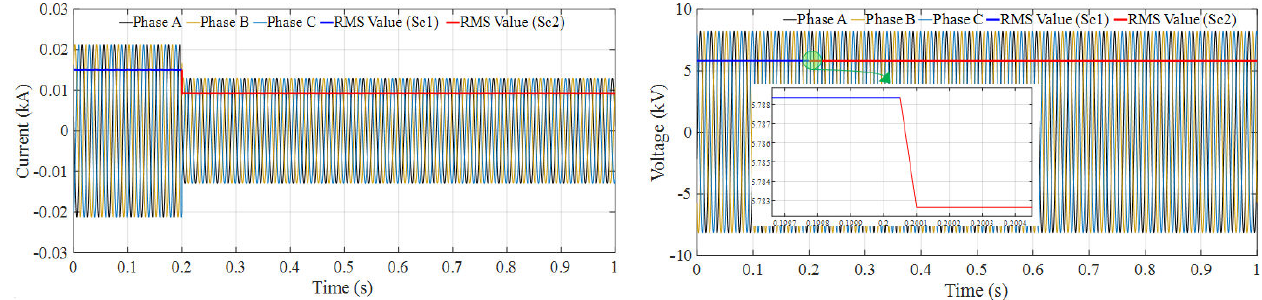
Figure 23. Voltage and current signals at the transformer primary side for scenario 1 and scenario